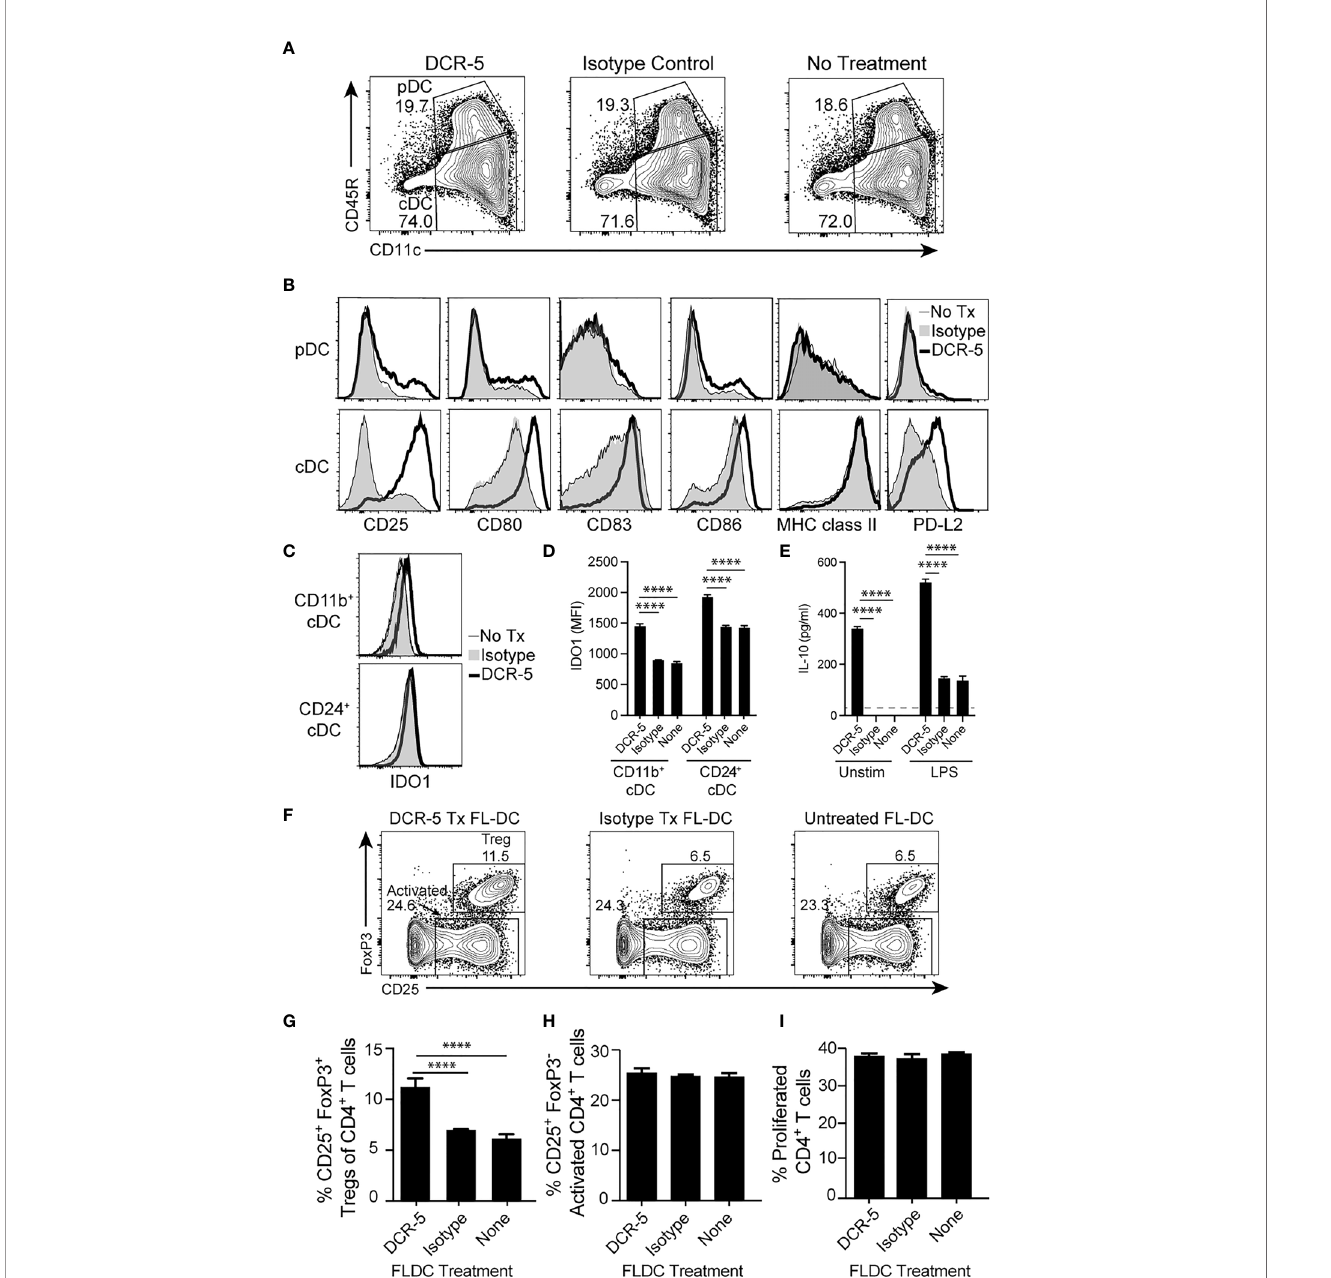
FIGURE 8 | DCR-5 binding to FL-DC population induces DCReg. (A) Flow cytometry plots showing gating of cultured B6 FL-DC cDC and pDC subsets after overnight culture with 20 µg/ml DCR-5, isotype control or no treatment and (B) histograms comparing their expression of maturation markers. (C) Representative histograms and (D) graph displaying fl ow cytometric intracellular expression (MFI) of IDO1 in FL-DC cDC subsets treated as above (n = 3). (E) Concentration of IL-10 in supernatants (n = 3) of FL-DC cultured for 48 h with 20 µg/ml DCR-5, isotype control or no antibody in the absence or presence of LPS stimulation. Dotted line shows limit of detection. (F) Representative contour plots and (G) graph (n = 3) of H-2K d+ CD4 + CD25 + FoxP3 + Treg generated from puri fi ed naïve BALB/c splenic T cells cultured at an 8:1 ratio for 3 days with washed B6 FL-DC after overnight treatment with DCR-5, isotype control or no treatment. (H) Graphs comparing CD25 + FoxP3 − T cells and (I) proliferated CFSE labeled CD4 + T cells in the same experiment. All groups compared by one-way ANOVA. ****p < detected in the sera from 2, 6, and 10 mg/kg DCR-5 treated speci fi city. Interestingly, despite sharing immunoglobulin animals by d36 with no signi fi cant differences between the constant regions with DCR-5, treatment with 10 mg/kg isotype groups. Spiking the DCR-5 treated mouse serum samples with control did not stimulate measurable production of antibodies DCR-5, reduced binding in the ELISA indicative of anti-DCR-5 capable of binding to DCR-5.